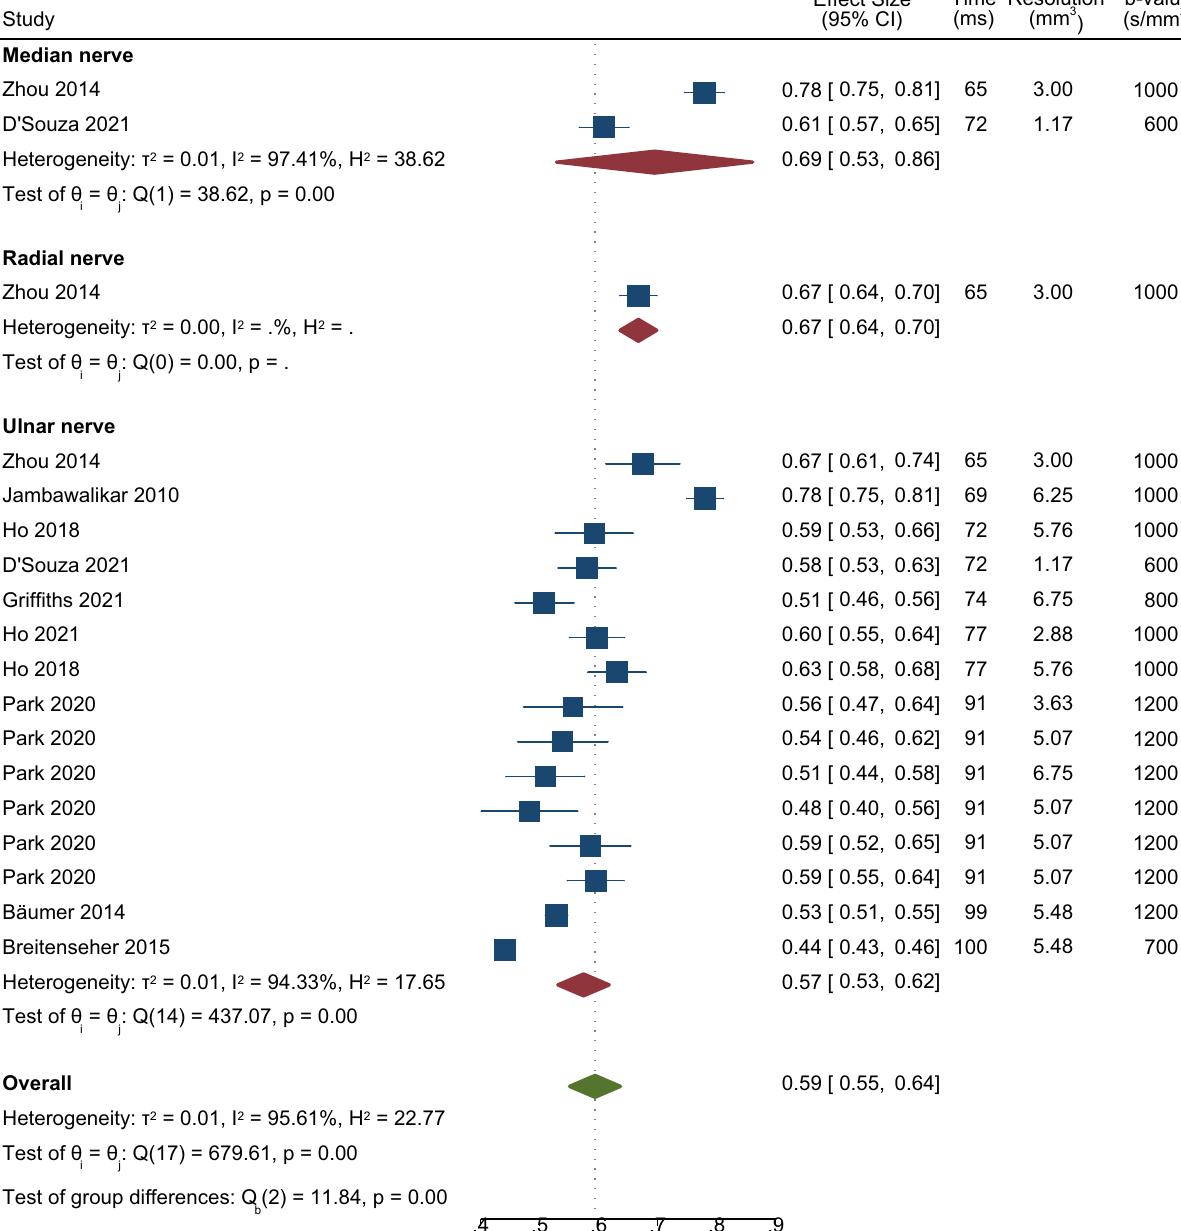
Figure 3. Forest plot of the normal FA of the median, ulnar and radial nerves within the forearm, sorted by the echo time and